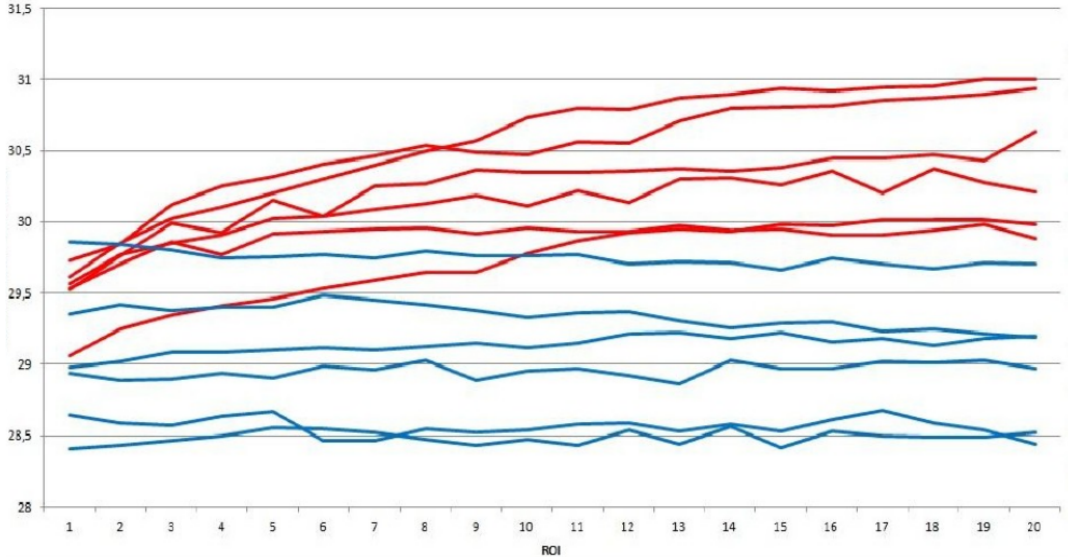
Figure 9. Time series of average temperature for sick (red) and healthy (blue)